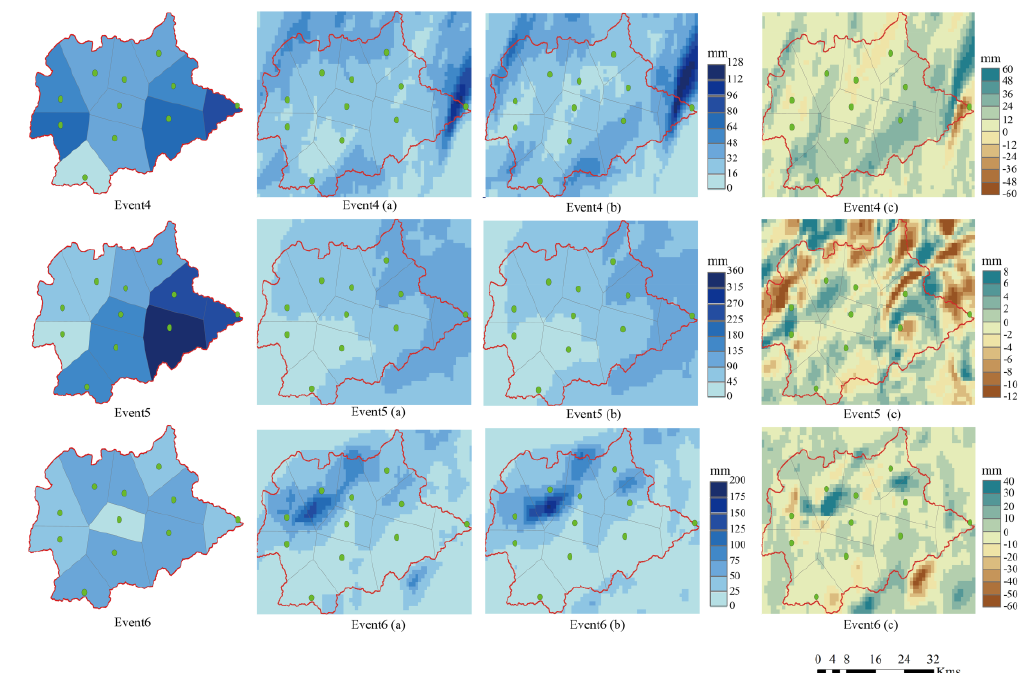
Figure 8. Spatial distributions of the 24 h accumulative rainfall for the three storm events in the Zijingguan catchment, from left to right: gauge observation; ( a ) WRF-only; ( b ) the fully coupled WRF / WRF-Hydro; ( c ) the fully coupled WRF / WRF-Hydro minus WRF-only.